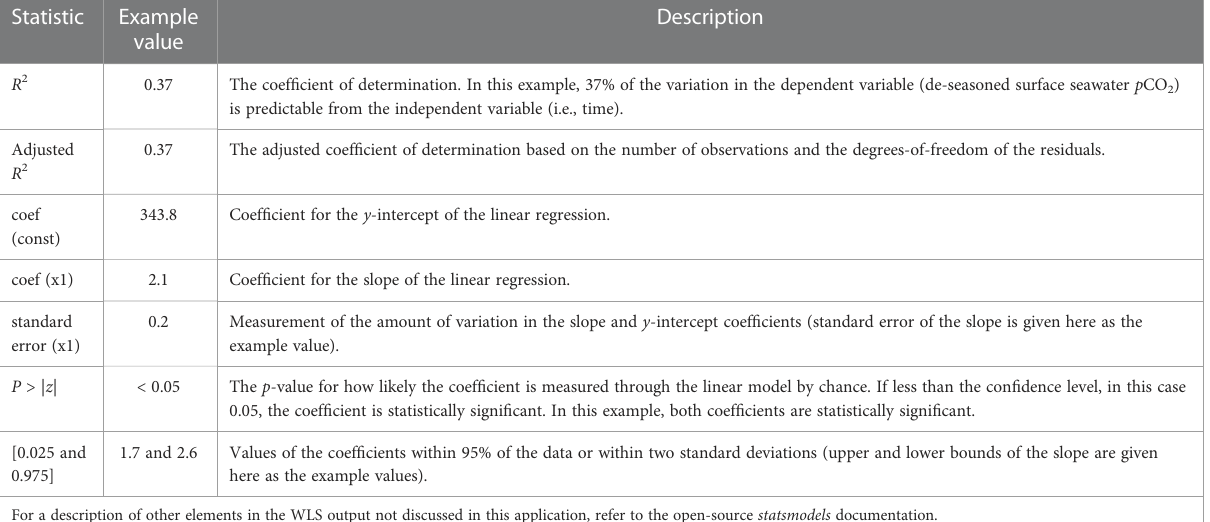
TABLE 1 A subset of statistics resulting from the WLS method of linear regression using the statsmodels Python package, including values generated by the example shown in Figure 5A and a description of each element.